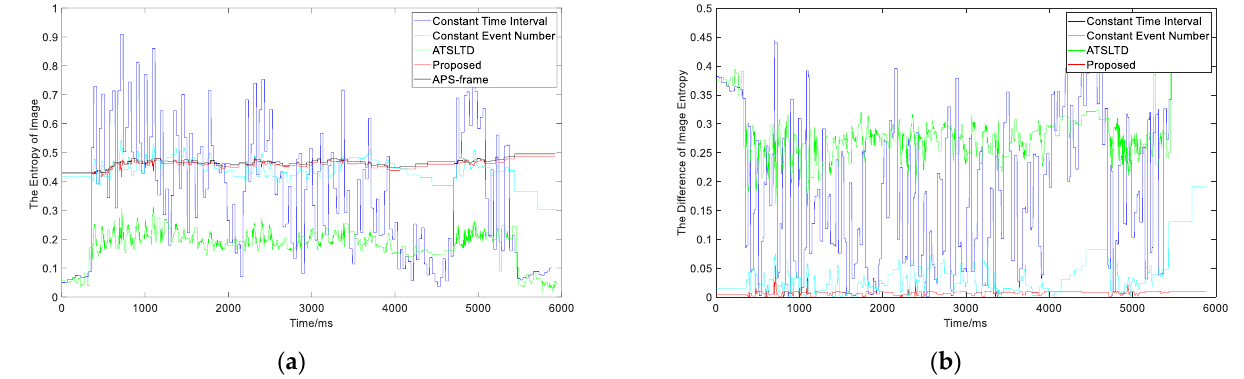
Figure 17. ( a ) The information entropy curve of virtual frame obtained by the four slicing methods and APS frame; ( b ) the difference curve between the information entropy of virtual frame obtained by the four methods and APS frame. Table 3. The mean value of the difference between the information entropy of virtual frame obtained by the four methods and APS frame.